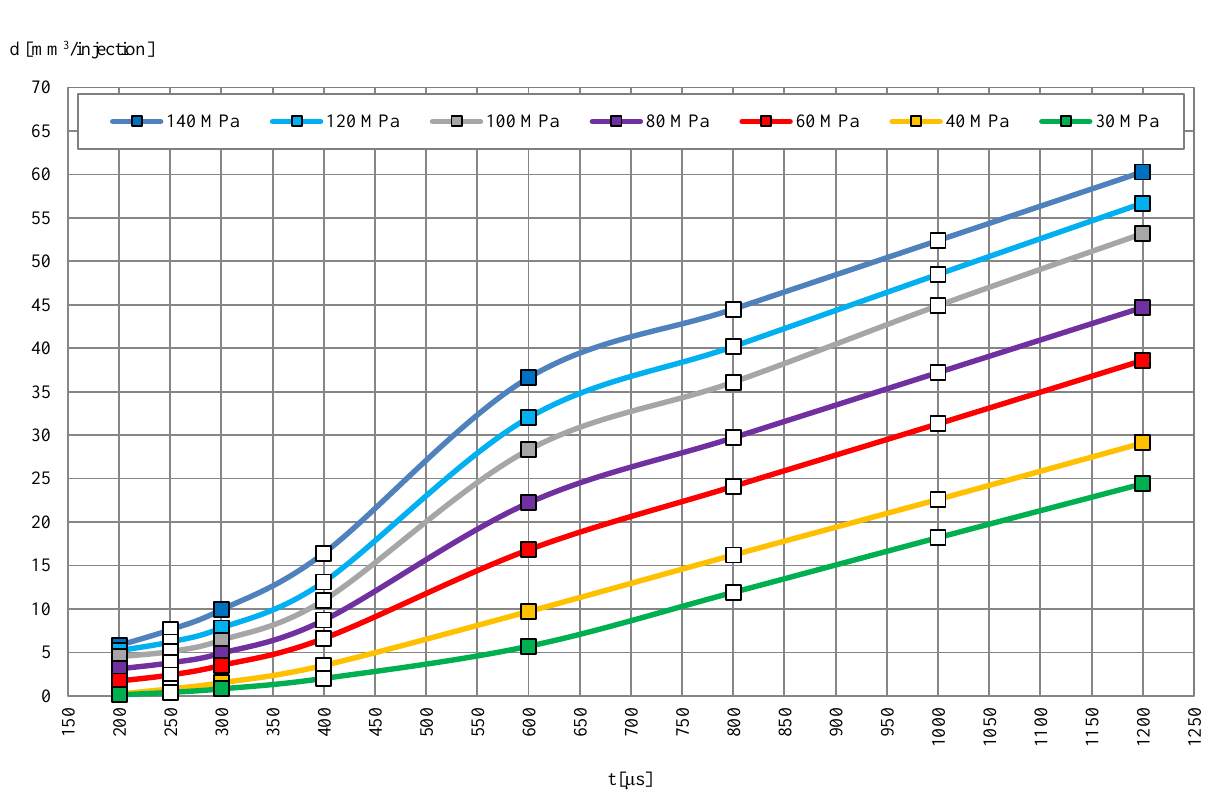
Fig. 6. Fuel doses characteristic curve for the injector